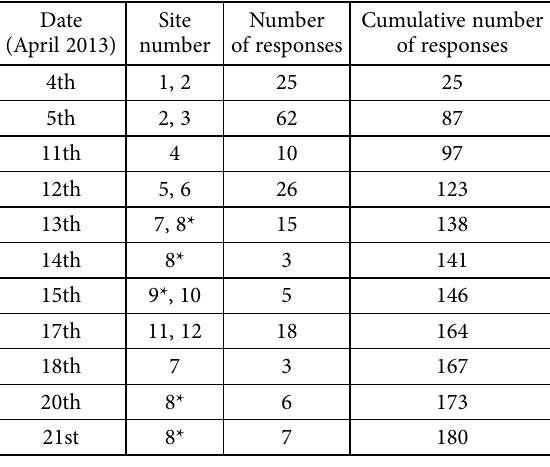
Table 3. Summary of survey sites and responses obtained